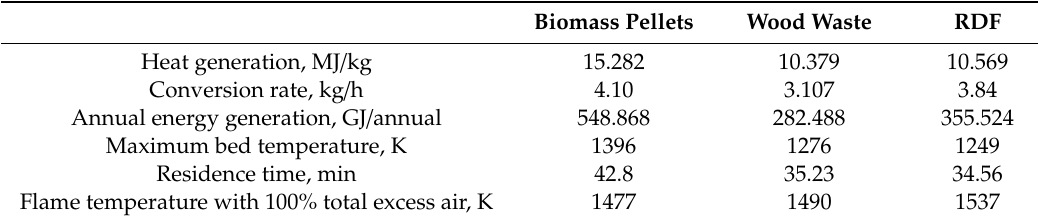
Table 5. Operational characteristics of the heating system for each fuel.